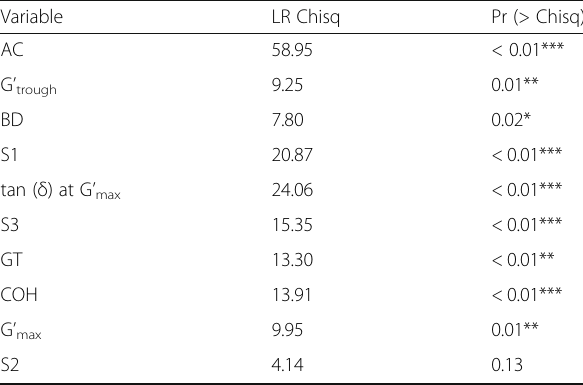
Table 4 Likelihood ratio (LR) test Variable LR